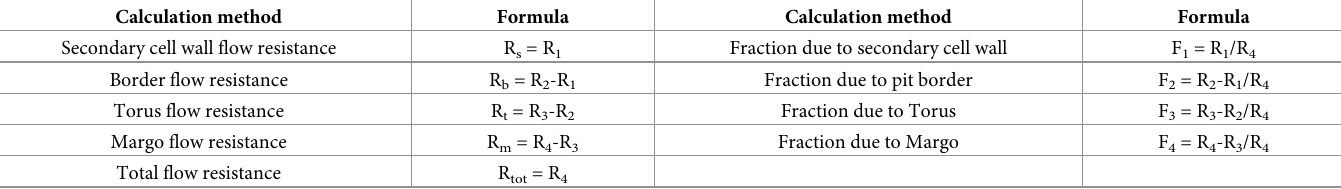
Table 4. Resistance calculation method.